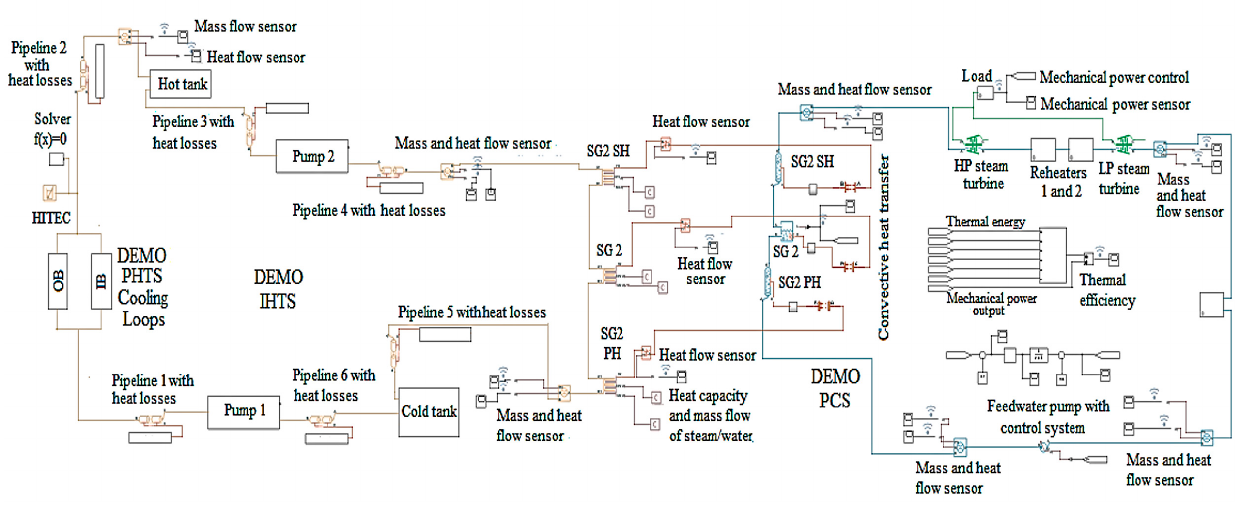
Figure 4. MATLAB/SIMULINK model of DEMO BOP ICD concept: the connection of DEMO PHTS with PCS via IHTS.